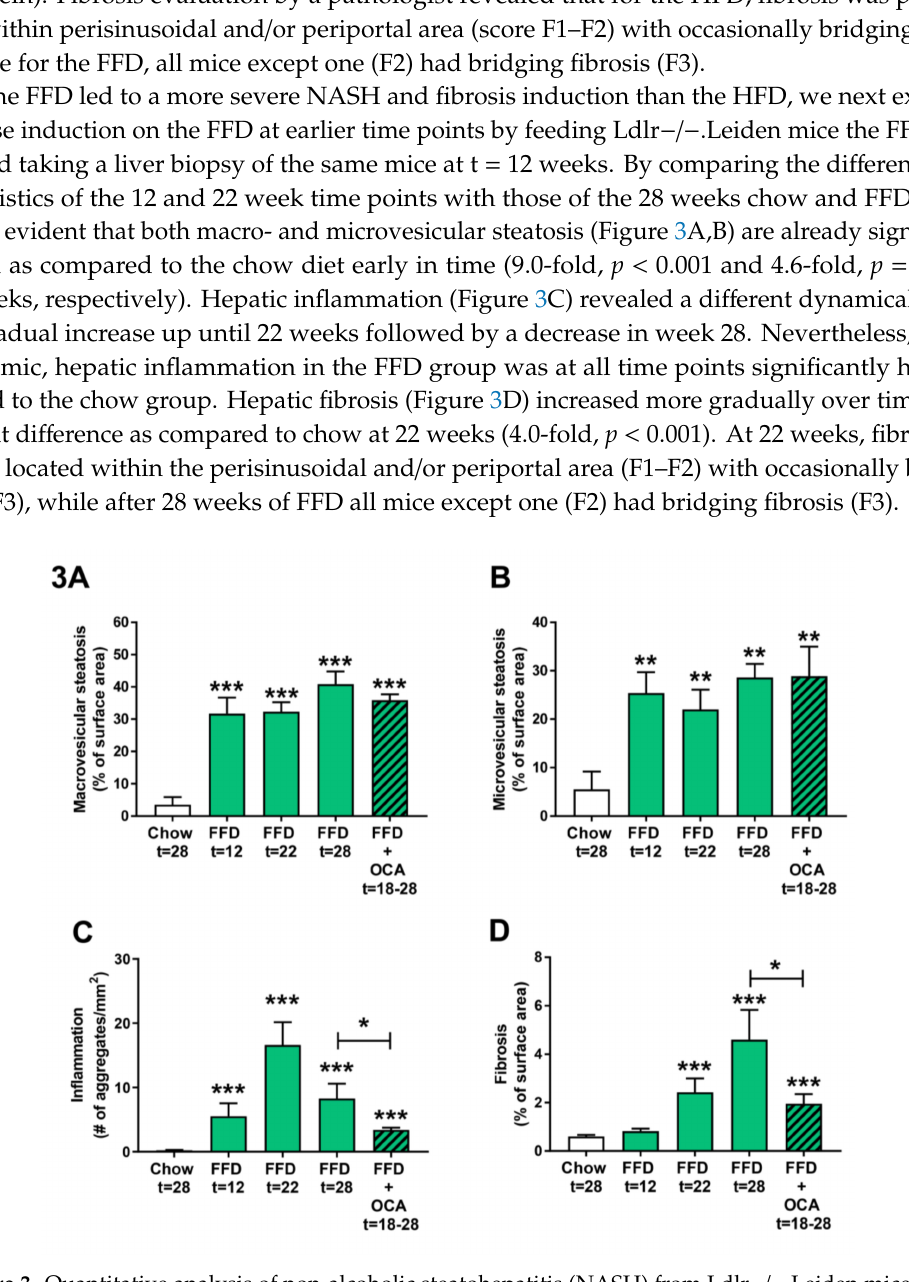
Figure 3. Quantitative analysis of non-alcoholic steatohepatitis (NASH) from Ldlr − / − .Leiden mice fed a healthy chow diet for 28 weeks or fed a fast food diet (FFD) containing milk fat for 12, 22, or 28